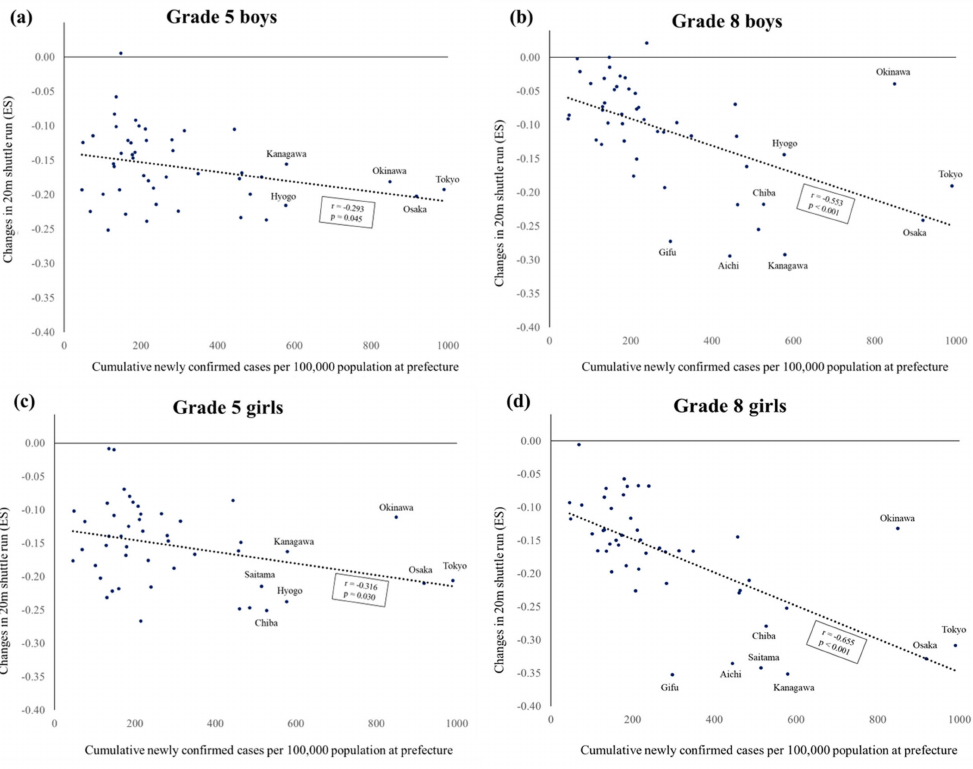
Figure 6. Association between the cumulative confirmed cases and changes in CRF at